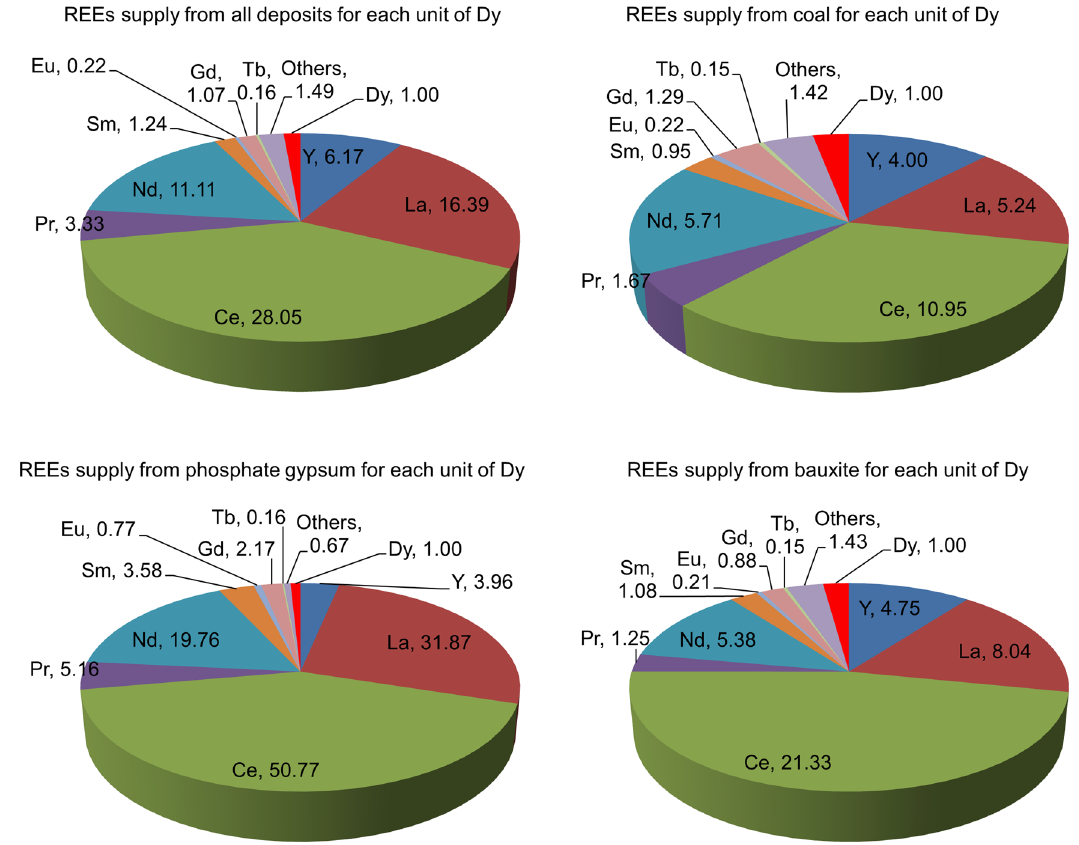
Fig. 10 Ratios of Dy production to other REEs production. Ratios of Dy production to other REEs production from coal, bauxite, phosphate gypsum and all traditional deposits (data on REE concentration in coal, phosphate gypsum, and bauxite, and for all deposits are taken from several sources 46,72 – 78,85